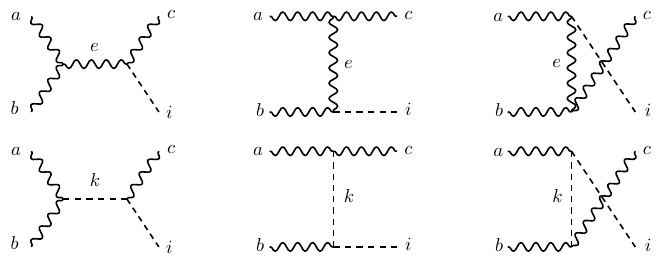
Figure 2 . Amplitudes for the scattering A a A b ! A c (cid:30) i